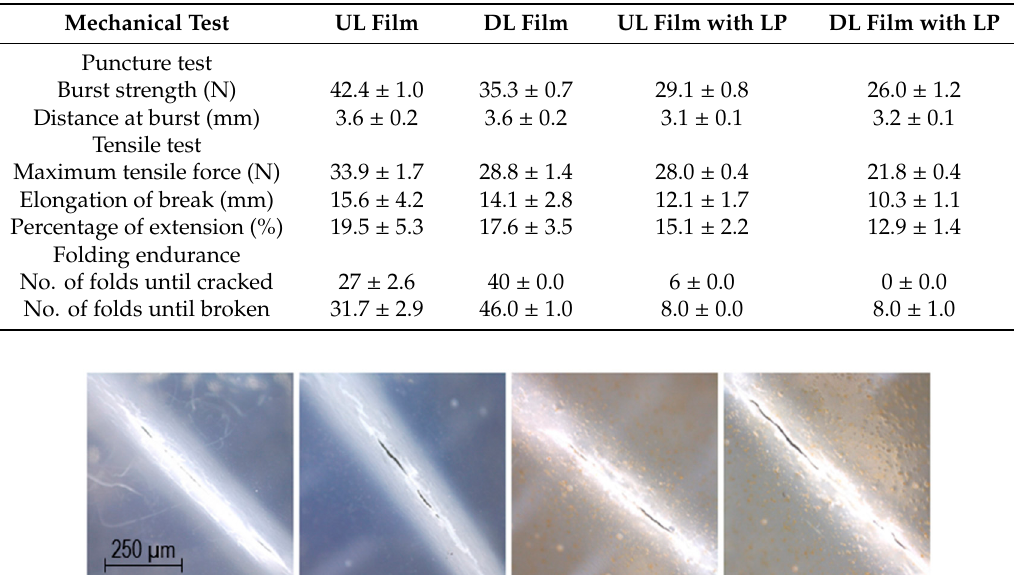
Table 5. Results from the three mechanical tests (puncture test, tensile test, and folding endurance) on the unloaded and drug-loaded films with and without liver powder, n = 6.